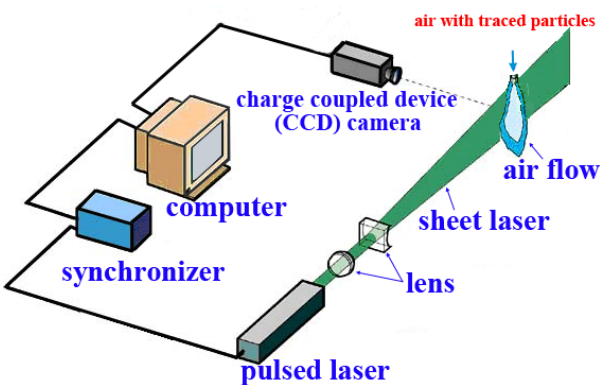
Figure 2. Schematic of the Particle Image Velocimetry (PIV) measurement system.